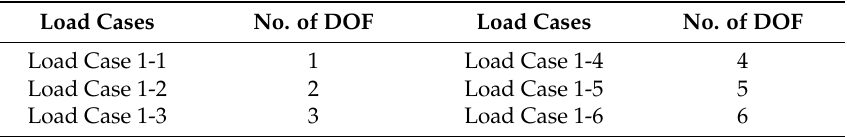
Table 3. Number of degree of freedom (DOF) excited in Load Cases 1-1 to